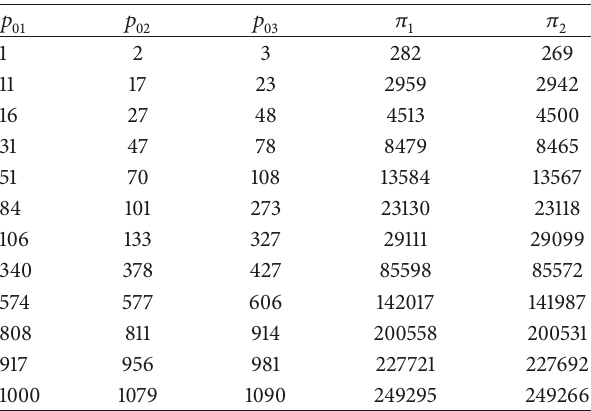
Table 5: The influence of the price on the